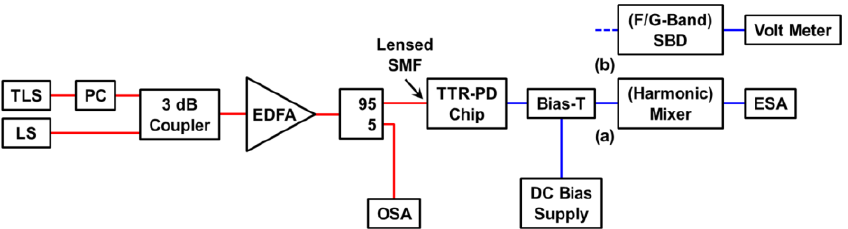
Figure 8. Measurement setup based upon optical heterodyne millimeter wave signal